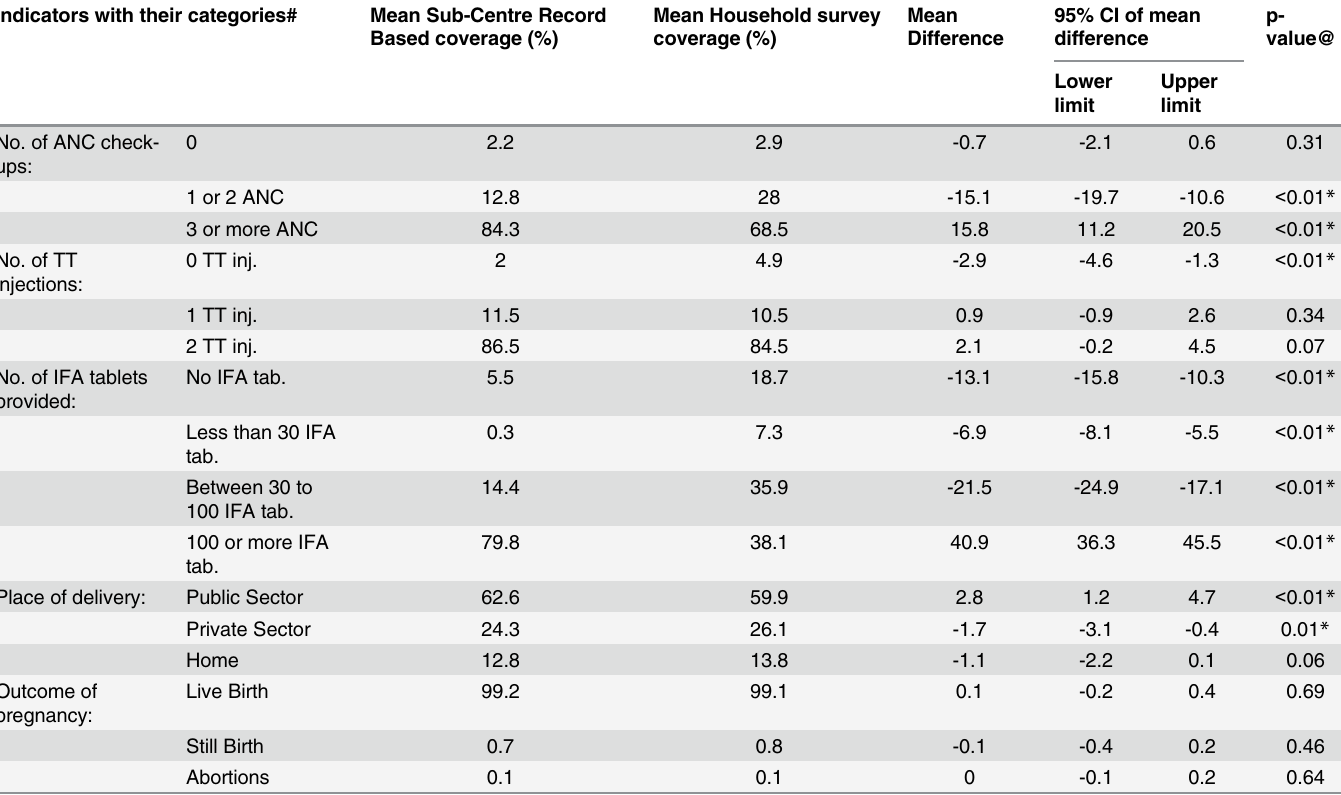
Table 2. Comparison between coverage of maternal and child health services in sub-centre records and household survey in Haryana state, India. Indicators with their